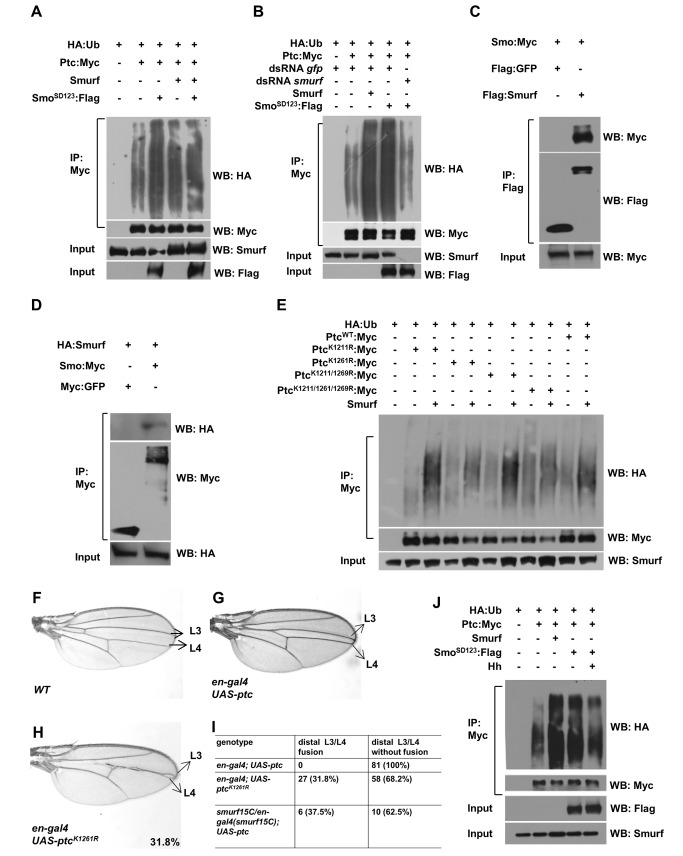
Smo promoted Smurf regulates Ptc ubiquitination through specific sites in Ptc C-tail.(A and B) S2 cells were transfected with combinations of DNA constructs as indicated. After 48 h transfection, S2 cells were treated with MG132 and NH4Cl for 4 h. Lysates from transfected S2 cells were immunoprecipitated with mouse anti-Myc affinity gel. Western blots were performed to analyze the presence of indicated proteins and levels of ubiquitination. (C and D) S2 cells were transfected with combinations of DNA constructs as indicated. After 36 h transfection, cells were treated with Hh medium for another 12 h to activate Hh signaling, lysates from transfected S2 cells were immunoprecipitated with anti-Flag M2 affinity gel (C) or anti-Myc affinity gel (D). (E) S2 cells were transfected with combinations of DNA constructs as indicated. After 48 h transfection, S2 cells were treated with MG132 and NH4Cl for 4 h. Lysates from transfected S2 cells were immunoprecipitated with mouse anti-Myc affinity gel. Western blots were performed to analyze the presence of indicated proteins and levels of ubiquitination. (F–H) Comparison of adult wing phenotype from wild-type flies (F), UAS-ptc overexpression driven by en-gal4 (G), and UAS-ptcK1261R overexpression driven by en-gal4 (H). (I) Phenotypic classification and statistics of flies with indicated genotypes, the ratio of fused veins between distal L3 and L4 in adult wing was measured in each genotype. (J) S2 cells were transfected with combinations of DNA constructs as indicated. After 48 h transfection, S2 cells were treated with MG132 and NH4Cl for 4 h. Hh medium was collected from a pMT-Hh stable transfected S2 cell line, and treated S2 cells for 12 h before cell harvesting. Lysates from transfected S2 cells were immunoprecipitated with mouse anti-Myc affinity gel. Western blots were performed to analyze the presence of indicated proteins and levels of ubiquitination.